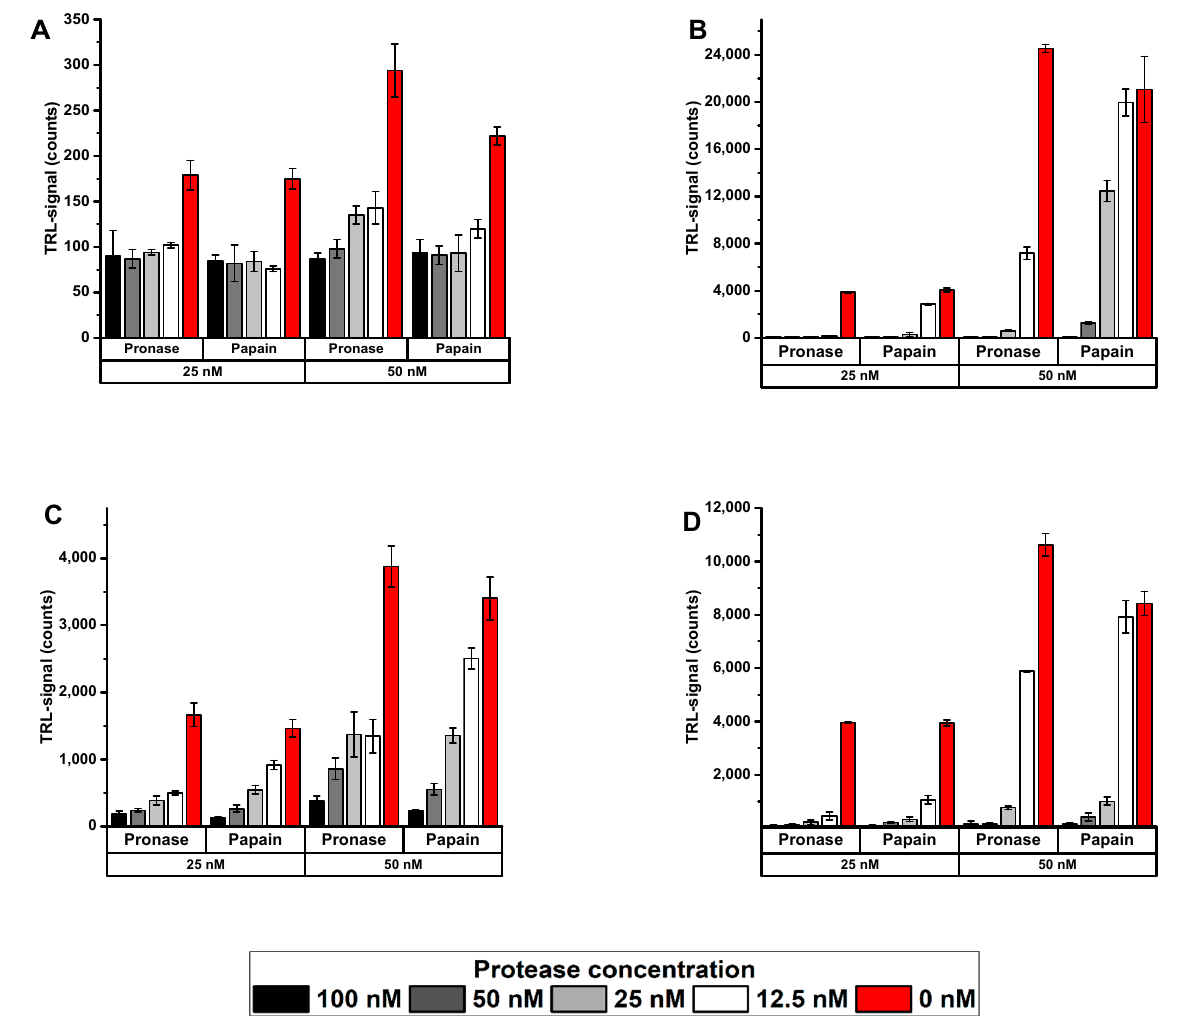
Figure 5. The digestion of MDH and eIF4A1 with pronase and papain. Pronase and papain (0–100 nM) were assayed with native MDH and eIF4A1 (25 or 50 nM) by using 10 min incubation at 37 ◦ C. The detection was performed directly after digestion at RT ( A , C ) or using the substrate post-denaturation after the digestion ( B , D ) to yield increase in the TRL-signal and substrate detectability. MDH gave only low TRL-signal at RT, which was increased significantly upon heating-induced post-denaturation of the target substrate. For eIF4A, increased TRL-signals were monitored upon thermal post-denaturation, but the protein was already detectable in its native form, even at 25 nM concentration. Data represent mean ± SD ( n = 3).